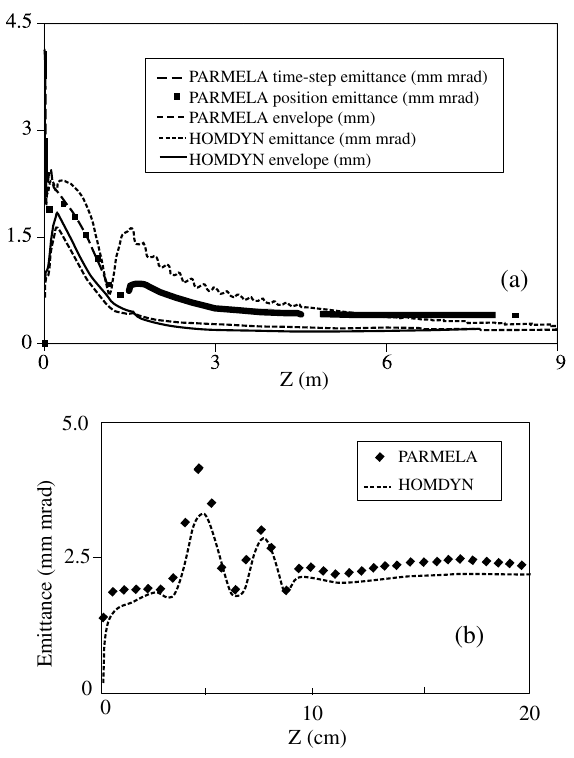
FIG. 5. Comparison between PARMELA and HOMDYN with the parameters listed in Table II. The simulation with PARMELA has been obtained with 10 4 macroparticles, a time step of 0.1 (cid:21) , and a mesh of 20 (cid:4) r (cid:5) (cid:10) 400 (cid:4) z (cid:5) points ( SCHEFF mode). The upper plot represents the first 20 cm of the